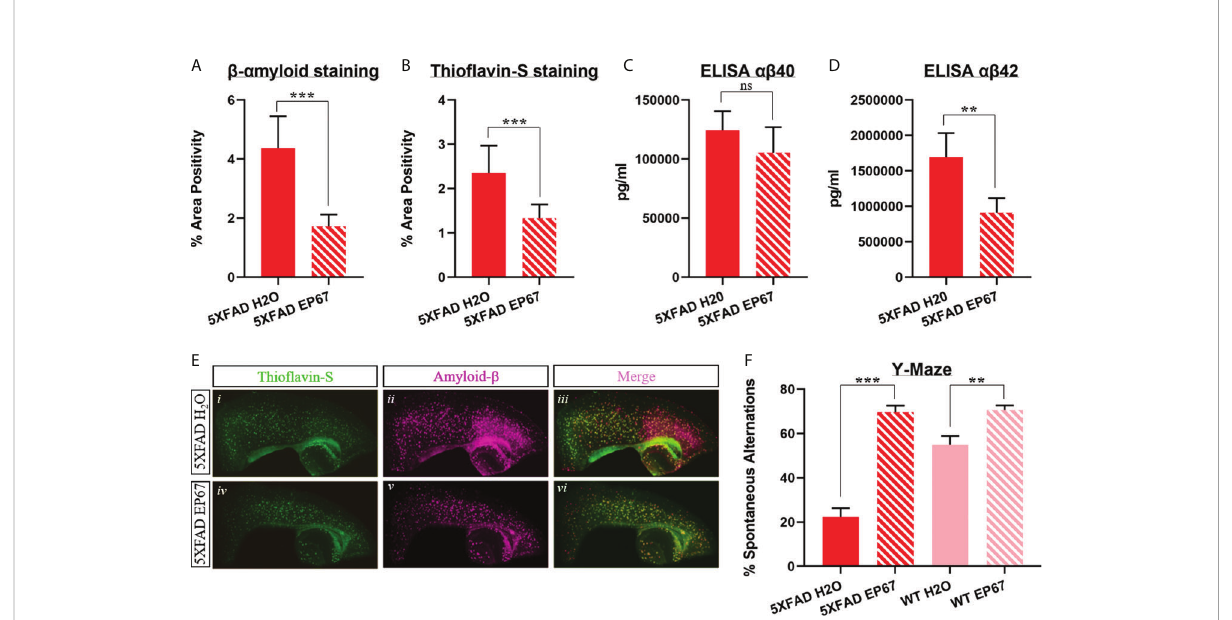
FIGURE 1 Amyloid load decrease and cognitive impairment amelioration in EP67 treated animals. (A, B) Sagittal brain sections from 5XFAD- and 5XFAD EP67-treated mice were co-stained with Thio fl avin-S (green; excitation l : 430; emission l : 550) and an anti-amyloid- b antibody (red; excitation l : 555; emission l : 580). (A) Measurements depicting b -amyloid staining were recorded separately, (B) as well as measurements representing Thio fl avin-S-positive plaques. (C, D) Whole hemisphere brain homogenates from 5XFAD and 5XFAD mice treated with EP67 ( via ELISA) were used to measure the amount of A b 40 (C) and A b 42 (D) . (E) Representative sections indicating Thio fl avin-S and b -amyloid staining in the cortex and hippocampus (composite fi gures from 200× images). (F) 5XFAD- and 5XFAD EP67-treated mice were given the spontaneous